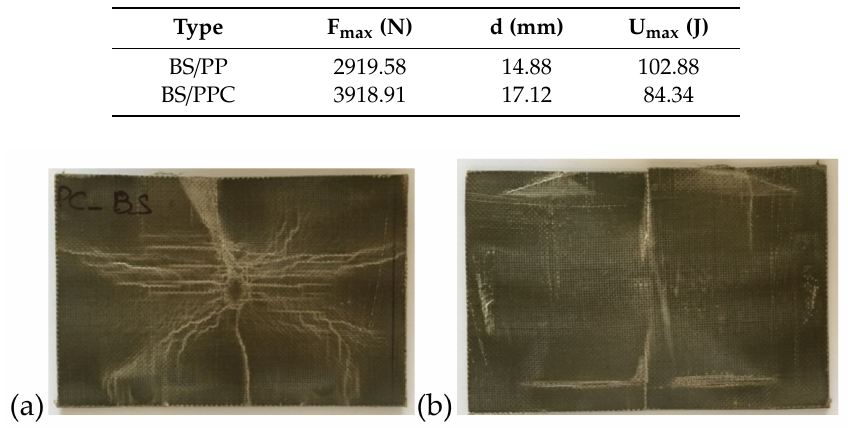
Table 3. Impact at penetration parameters for both composite systems.